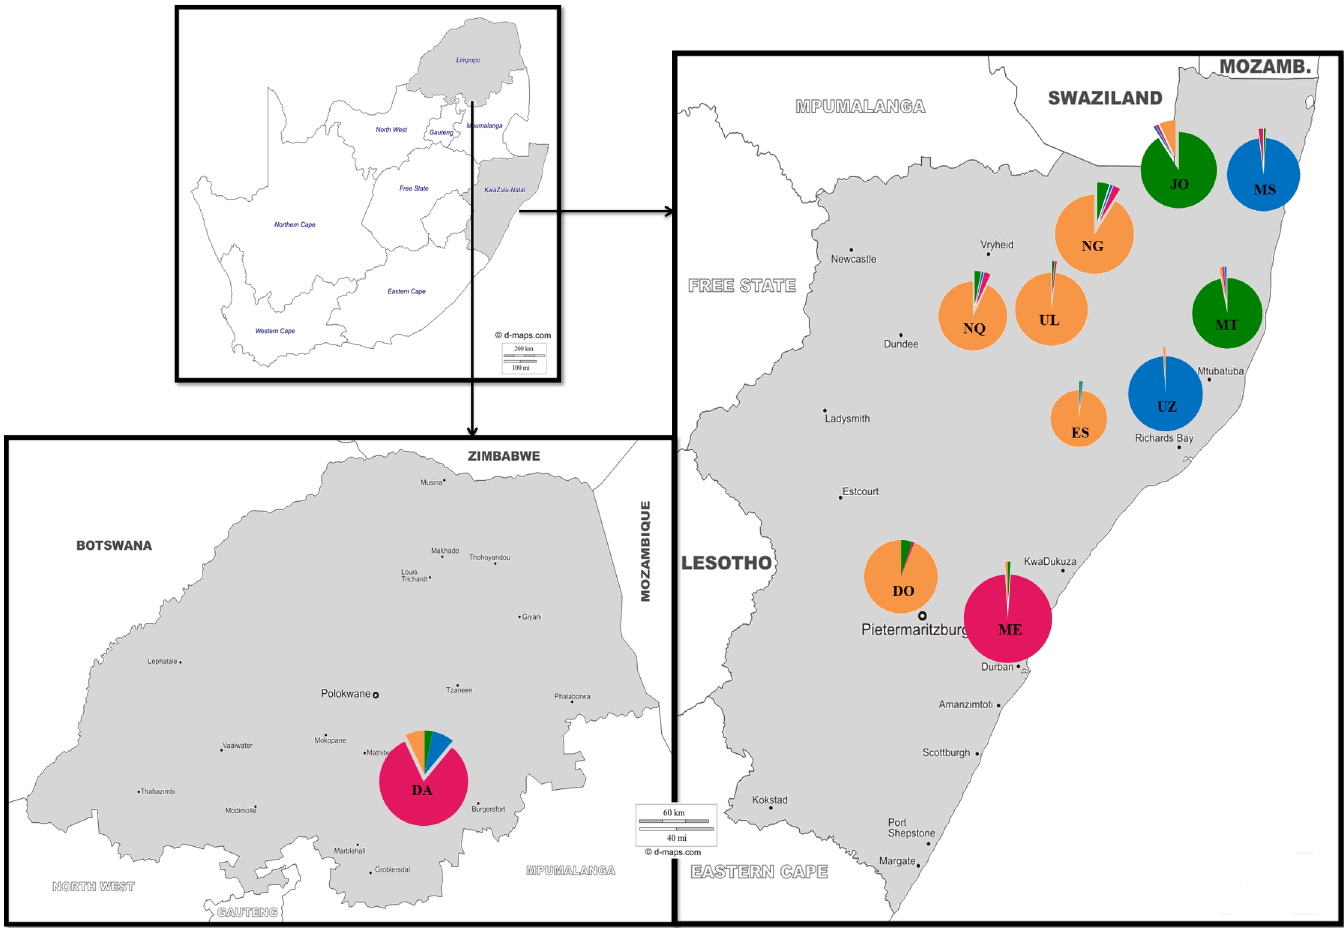
Fig 3. Representation of sample size (indicated by diameter of the pies) and of relative admixture distribution (indicated by different colour) inferred by STRUCTURE at K = 4. JO, Jozini; MT, Mtubatuba; NG, Nongoma; ES, Eshowe; UL, Ulundi; NQ, Nquthu; UZ, UNIZULU research station; MS, Makhathini research station; DO, Dorper; DA, Damara; ME, South African Merino.Source: figure taken from http://www.d-maps.com and adapted for illustrative purpose only.